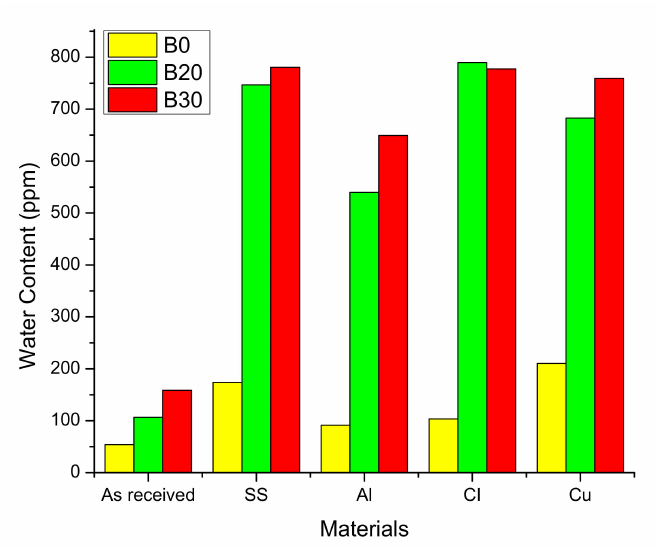
Figure 9. Change in water content of biodiesel after the immersion test with different materials.